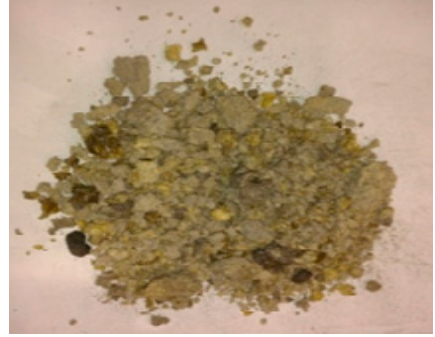
Figure 2. Coal bottom ash.